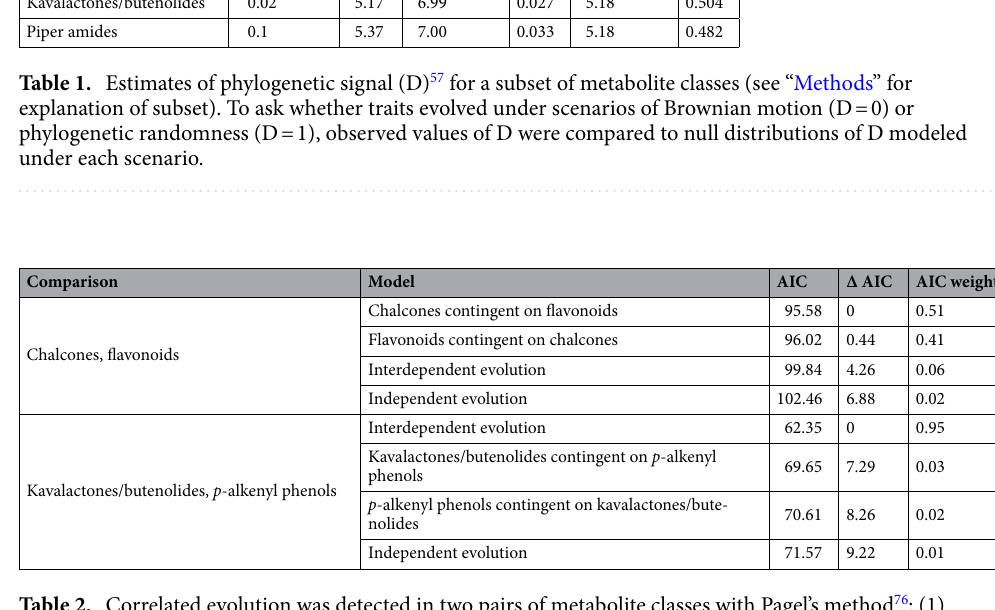
Table 2. Correlated evolution was detected in two pairs of metabolite classes with Pagel’s method 76 : (1) chalcones and flavonoids; and (2) kavalactones/butenolides and p -alkenyl phenols. A model comparison framework was employed to evaluate four potential models of trait evolution using AIC: interdependent evolution (transition rate in one trait depends on state at another, and vice versa); contingent change (transition rate in one trait depends on state at another, but not the converse); and independent evolution.